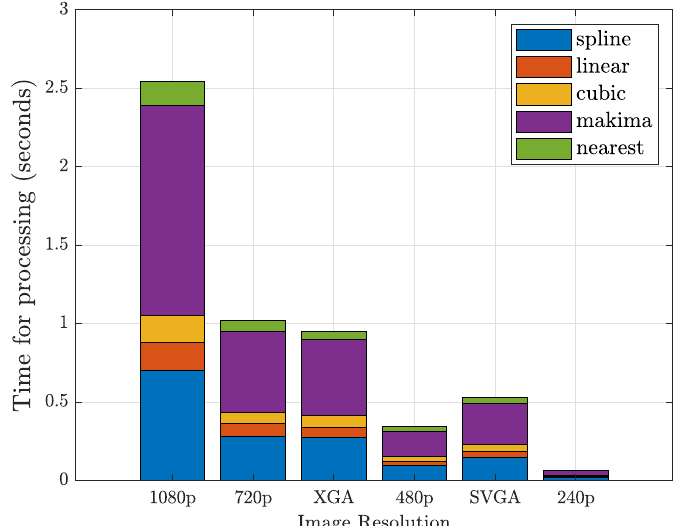
Figure 2. Image processing time for proposed algorithm on different resolution and interpolation.